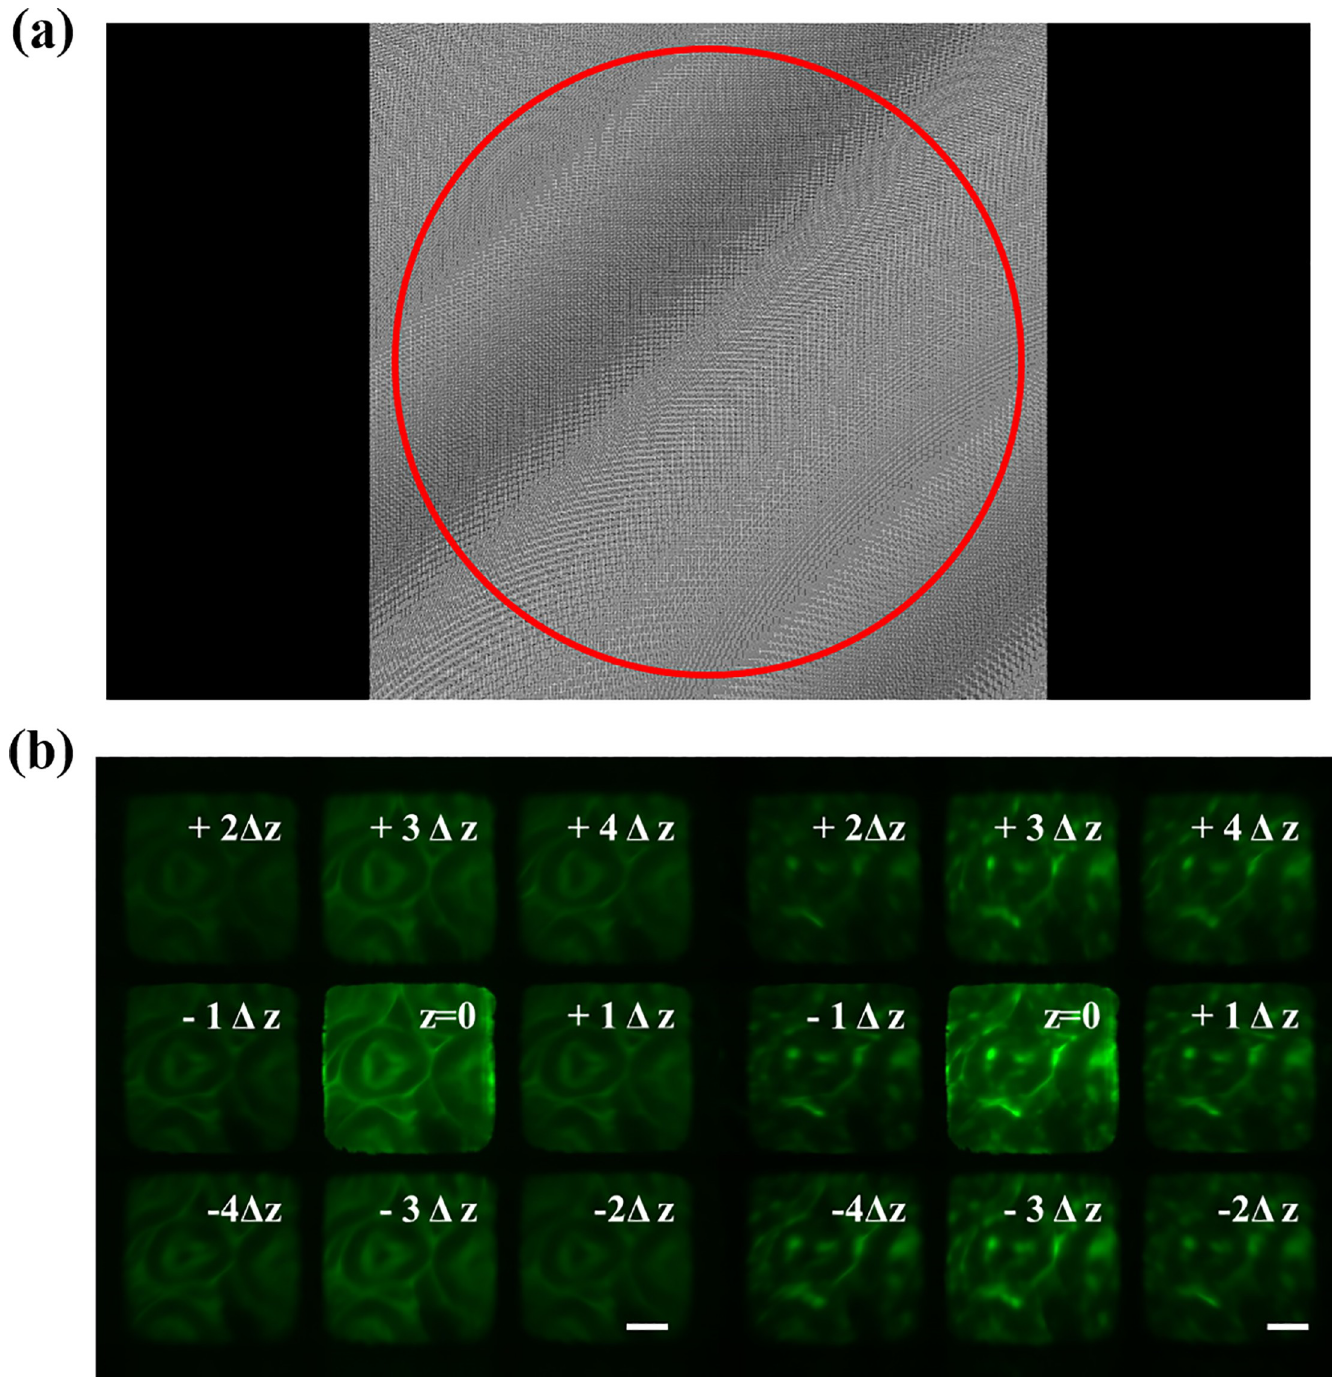
Fig 2. Calculated phase pattern and the raw images with uniform and speckle illumination (a) Phase pattern for the MFM calculated based on the weighted global GS algorithm, where the red circle represents the back aperture area relayed from the objective; (b) raw images of mouse kidney slices under uniform illumination (left) and speckle illumination (right). Scale bar = 15 μ